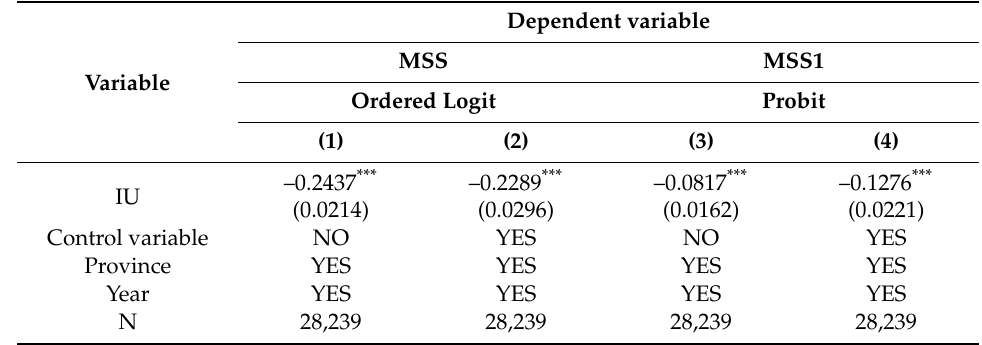
Table 8. Internet use and medical service satisfaction: Ordered logit and probit